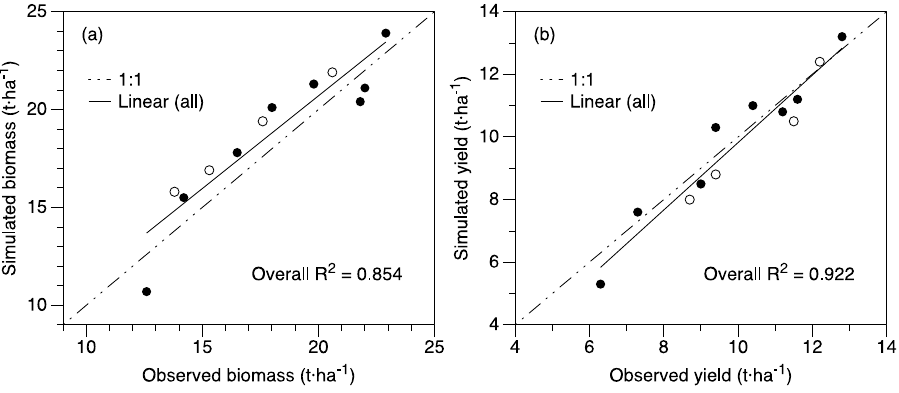
Figure 4. Relation between measured and simulated values for ( a ) biomass and ( b ) grain yield for the calibration dataset (open circle) and validation dataset (filled circle).